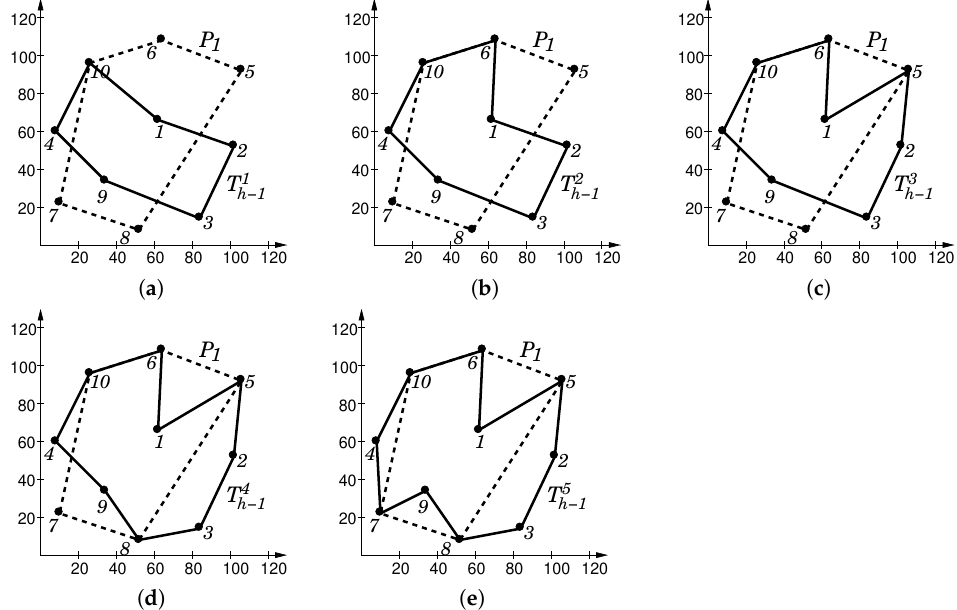
Figure 19. Graphs corresponding to the iterations carried out by Algorithm 4 ( JOINP ) for the construction of tour T 2 . ( a ) T 1